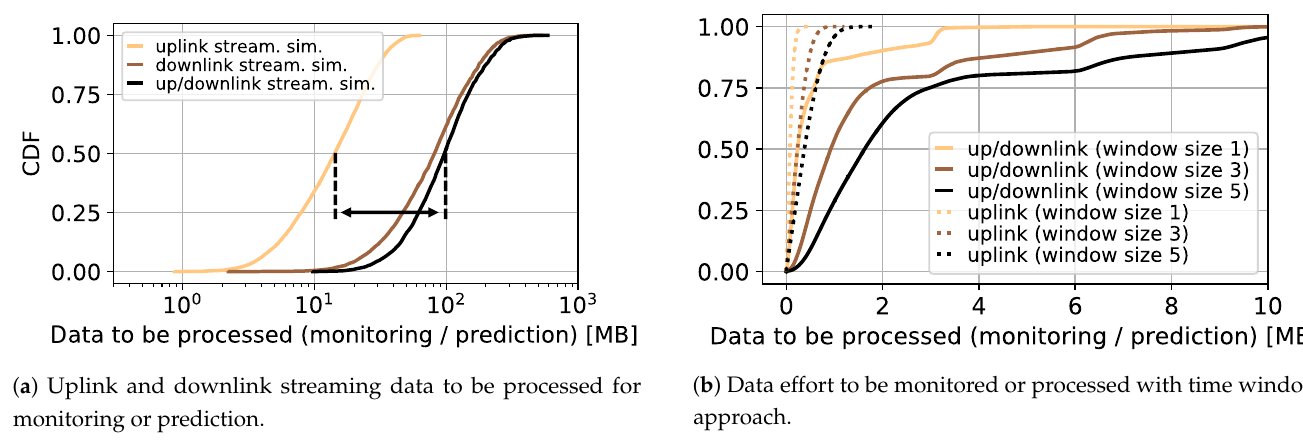
Figure 1. Streaming simulation results.